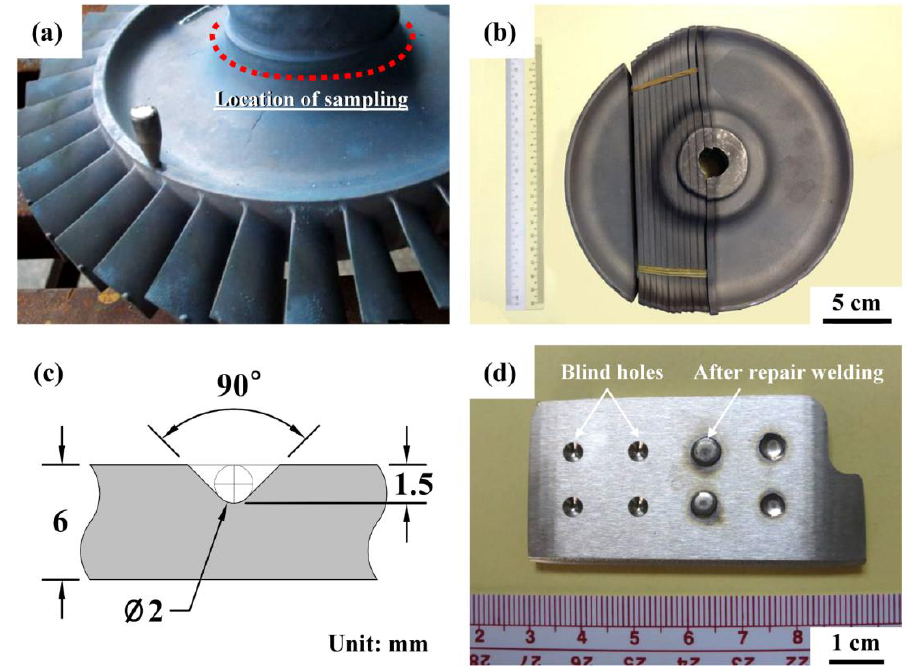
Figure 1. ( a ) The macro-view of the cast turbine; ( b ) the tested sample cut from the turbine; ( c ) the joint geometry of the repair weld; and ( d ) the macro-view of the repair